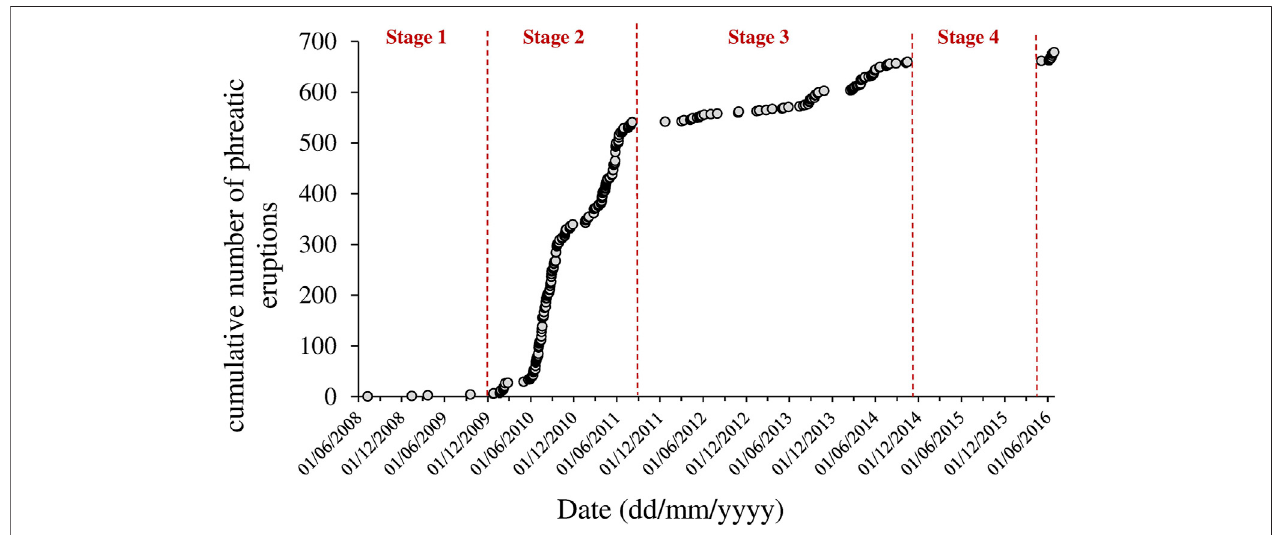
FIGURE 2 | Cumulative number of phreatic eruptions vs. time. Four stages of activity are identi fi ed: 1) low frequency of phreatic eruptions, 2) high frequency of phreatic eruptions, 3) decline of phreatic eruptions, and 4) a period of quiescence.